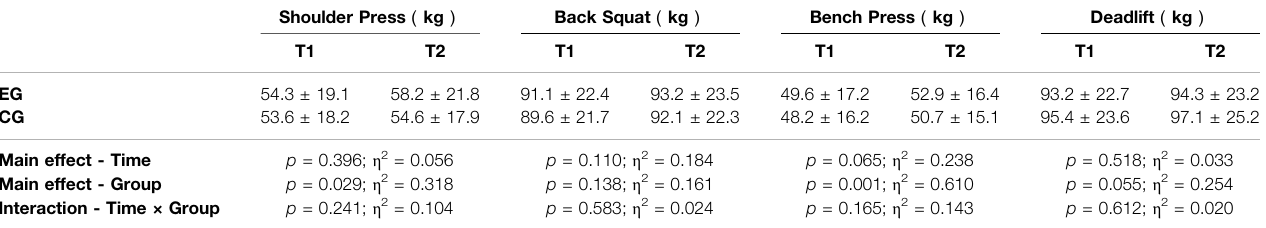
TABLE 2 | Comparison of 10RM of the back squat, bench press, deadlift, and shoulder press (kg).